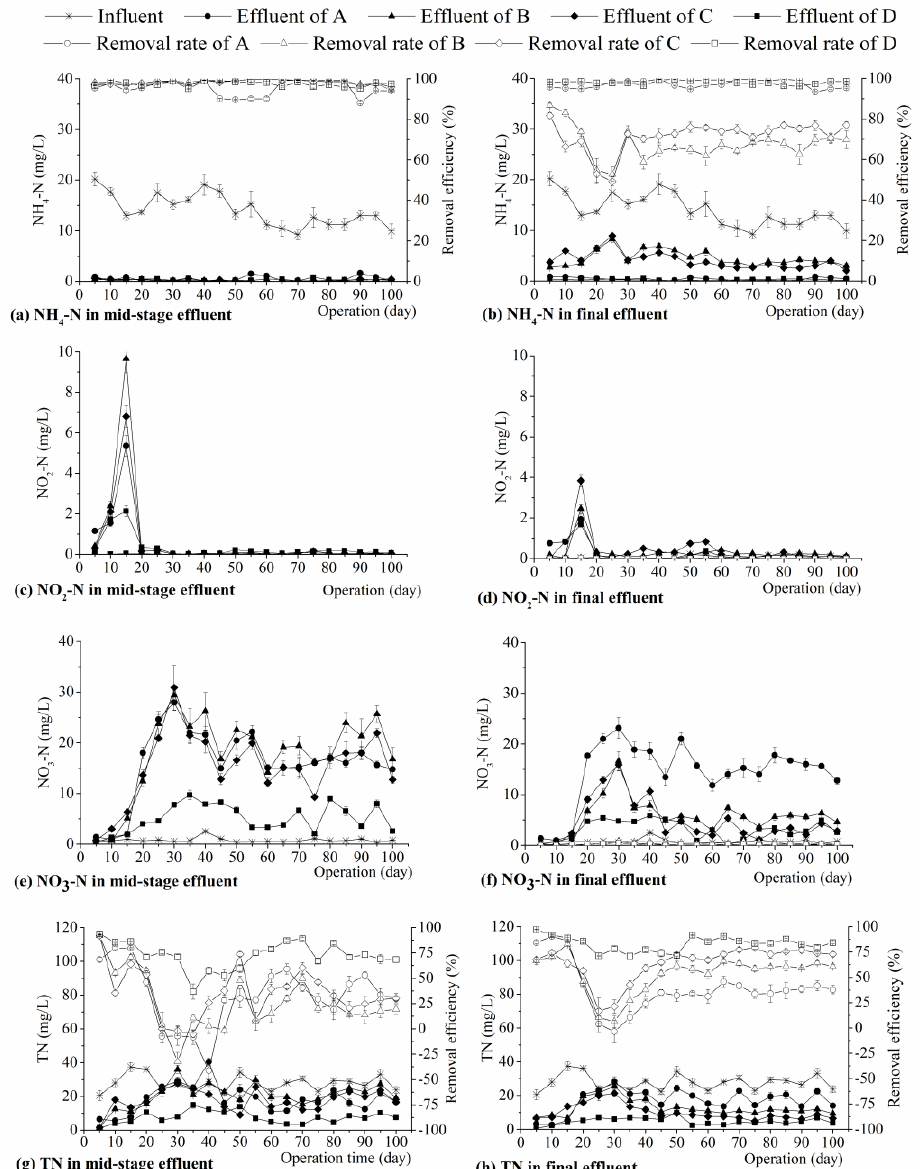
Figure 4. Nitrogen concentrations and removal efficiencies in different experimental MSL-SWI systems. ( a ): NH 4 -N in mid-stage effluent; ( b ) NH 4 -N in final effluent; ( c ) NO 2 -N in mid-stage effluent; ( d ) NO 2 -N in final effluent; ( e ) NO 3 -N in mid-stage effluent; ( f ) NO 3 -N in final effluent; ( g ) TN in mid-stage effluent; ( h ) TN in final effluent.